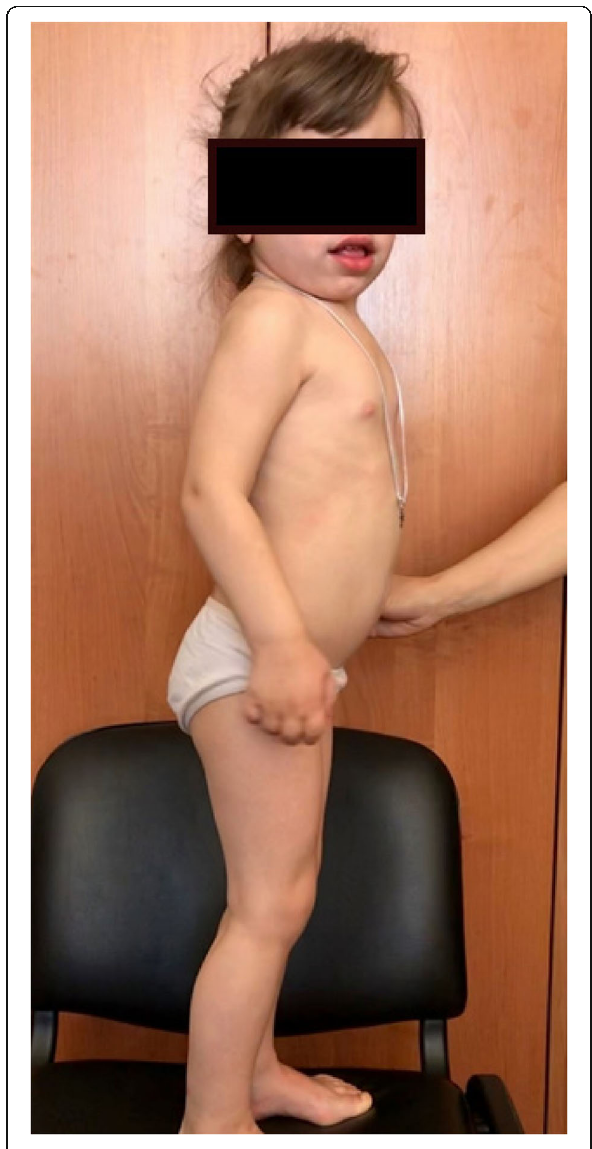
Fig. 1 A 4-year old girl with Hunter